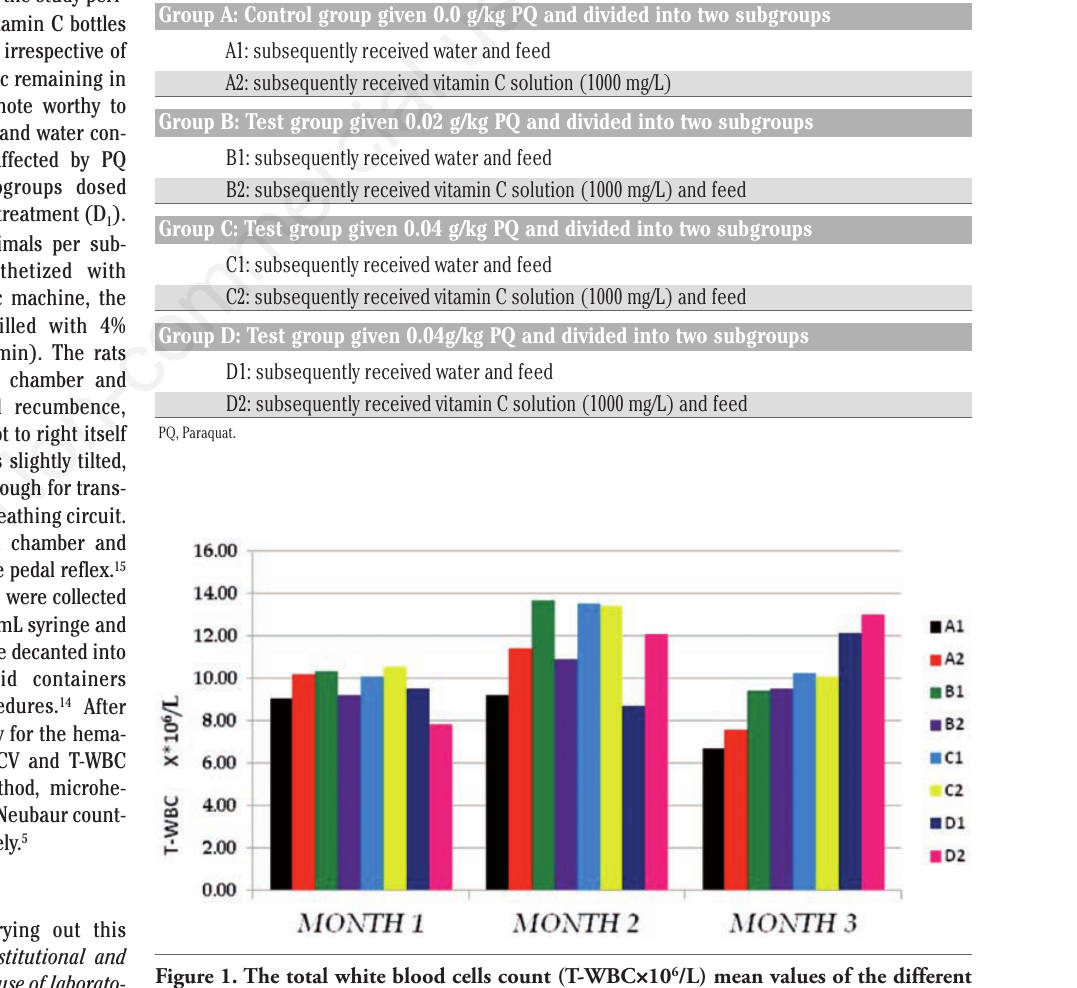
Table 1. Treatment chart for the